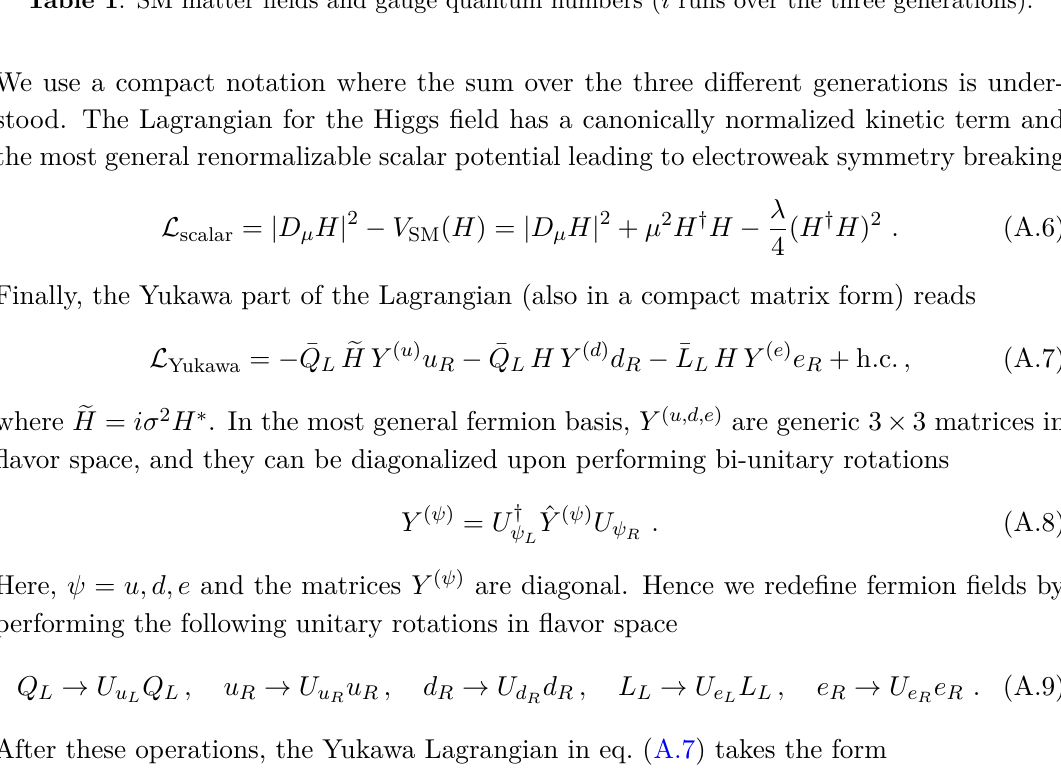
Table 1 . SM matter fields and gauge quantum numbers ( i runs over the three